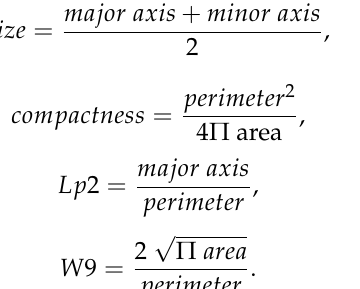
Figure 3. Digital light microscopy images of EB samples after different dispersion operations: ( a ) reference powder, ( b ) 15 days of exfoliation (I), ( c ) horizontal bead mill (II), ( d ) three-roll mill (III) with medium M1, ( e ) three-roll mill (III) with medium